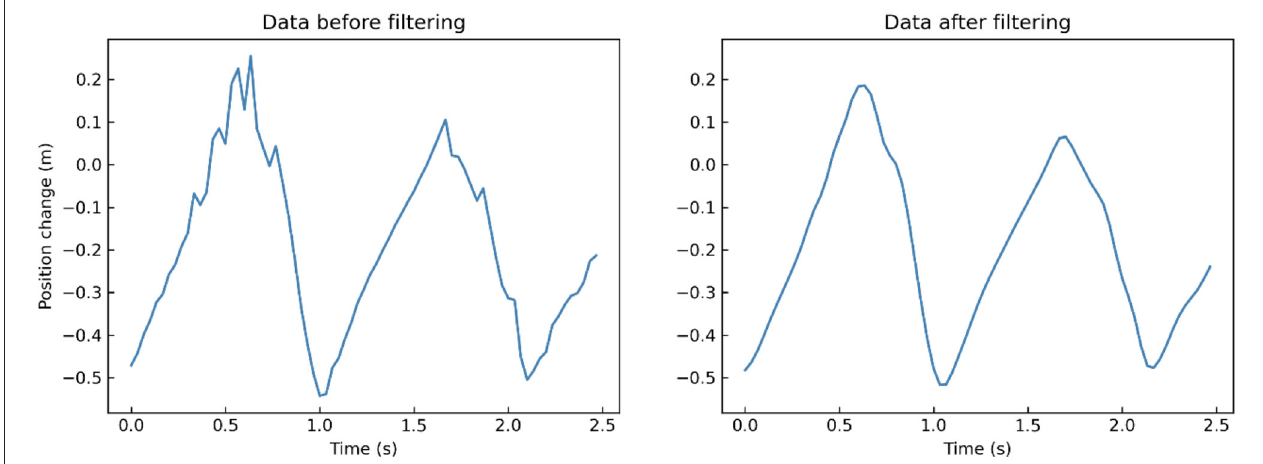
FIGURE 4 | A segment of one participant’s left-foot (joint 24) data on Y-axis when walking toward Kinect before ( left ) and after ( right ) low-pass